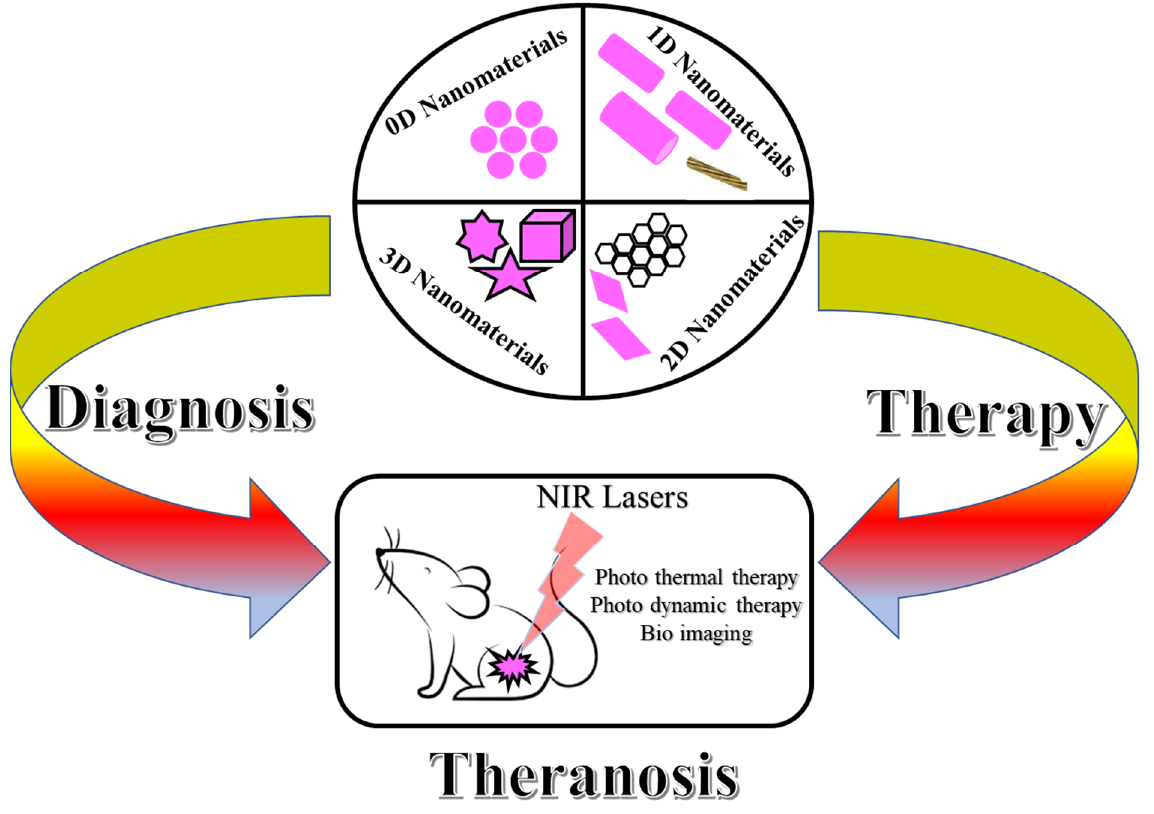
Figure 4. The scheme represents the application of 0D, 1D, 2D & 3D nanomaterials application in theranosis.